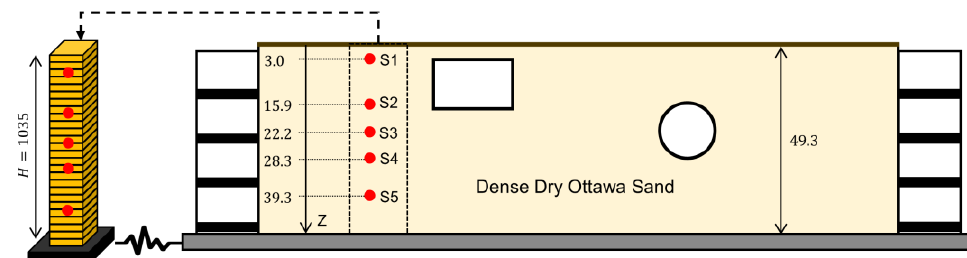
Figure 15. Validation case study using a centrifuge experiment: ( right ) soil domain and the instru- mentation and ( left ) the FE model (all dimensions are in cm).